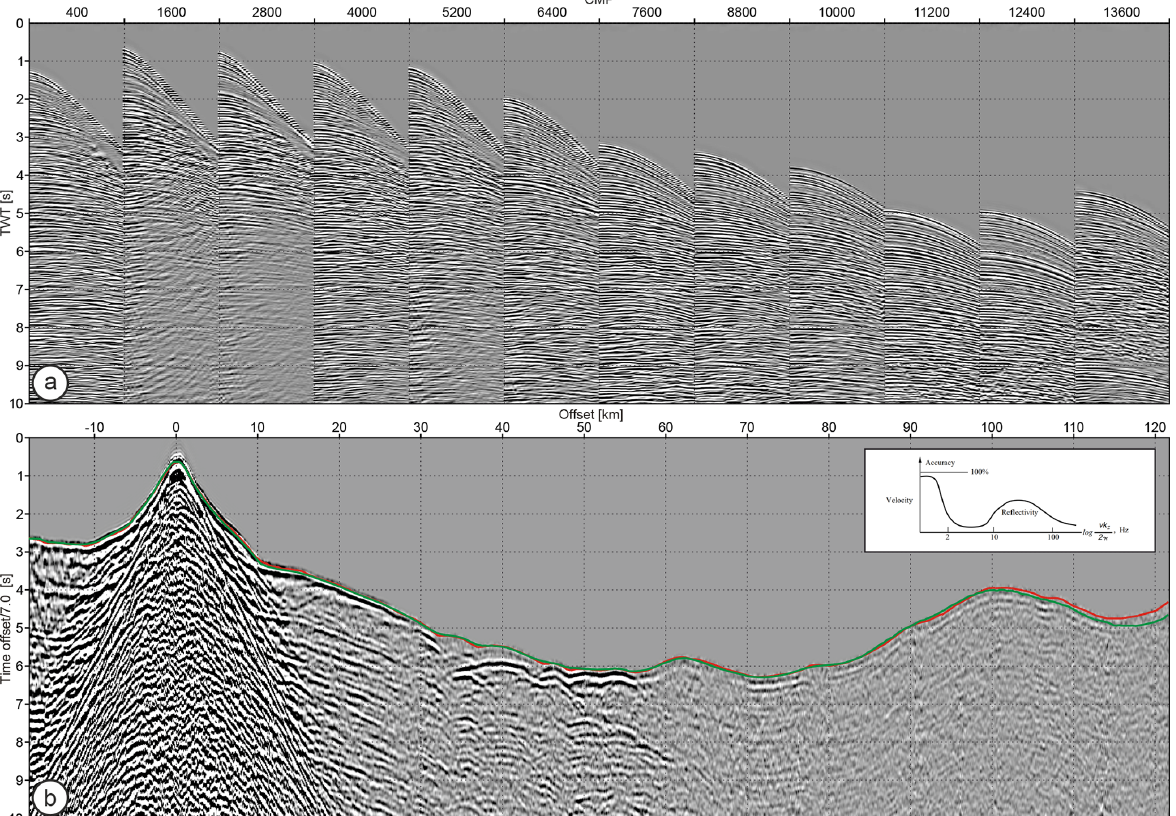
Figure 2. (a) Example of MCS data sorted into CMP gathers extracted along the whole profile. Each 1200th CMP gather is displayed. (b) Example of a single OBS gather. The red and green lines show picked and synthetic travel times, with the latter being computed in the FAT velocity model. The match between the two lines gives some insight on the kinematic accuracy that may need to be achieved to prevent cycle skipping during subsequent FWI. Note also the challenging picking of first arrivals between 35 and 45km of offset, whereby weak-amplitude first arrivals correspond to head waves that propagate along a thrust in the backstop. See Górszczyk et al. (2017) for details. Inset in (b) presents a resolution gap between tomographic velocity models and migration images (Fig. 1.13 of Claerbout,